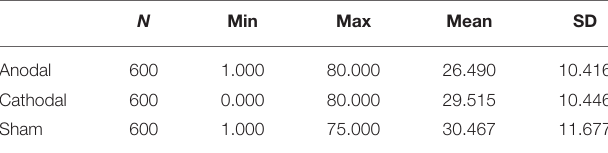
TABLE 2 | Summary of the individual